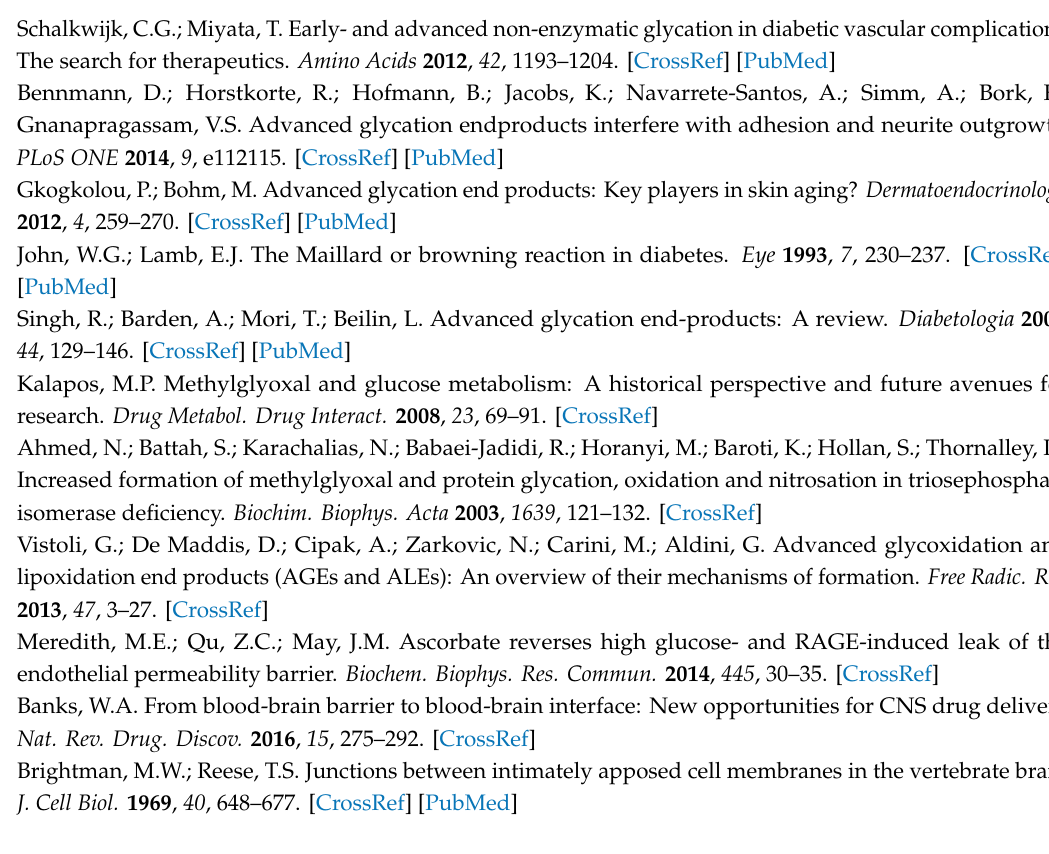
Figure S1: Measurement of Colony Building Units (CBU) at an optical density with a range from 4.5 to 5.5. at 570 nm (a). Transendothelial electrical resistance measured in the BBB model of THBMEC after di ff erent time points and treatments (b, c), Figure S2: Heat map analysis of high-throughput multiplex barrier qPCR data of THBMEC cells in comparison to hCMEC / D3 cells as positive control, set to 1.0. Total RNA extracts were pre-amplified and the Ct values of the targets were normalized to the endogenous control B2M after qPCR, Figure S3: Expression levels of RAGE in THBMECs with or without MGO treatment. THBMECs were incubated with 0.15 mM MGO for 1 h in serum-free medium. Total protein was separated using SDS-PAGE. Expression of RAGE was detected by immuno-blotting using anti-RAGE-antibody (ab3611) (a). Tubulin detected with an anti-tubulin antibody as well as Ponceau S staining served as loading control